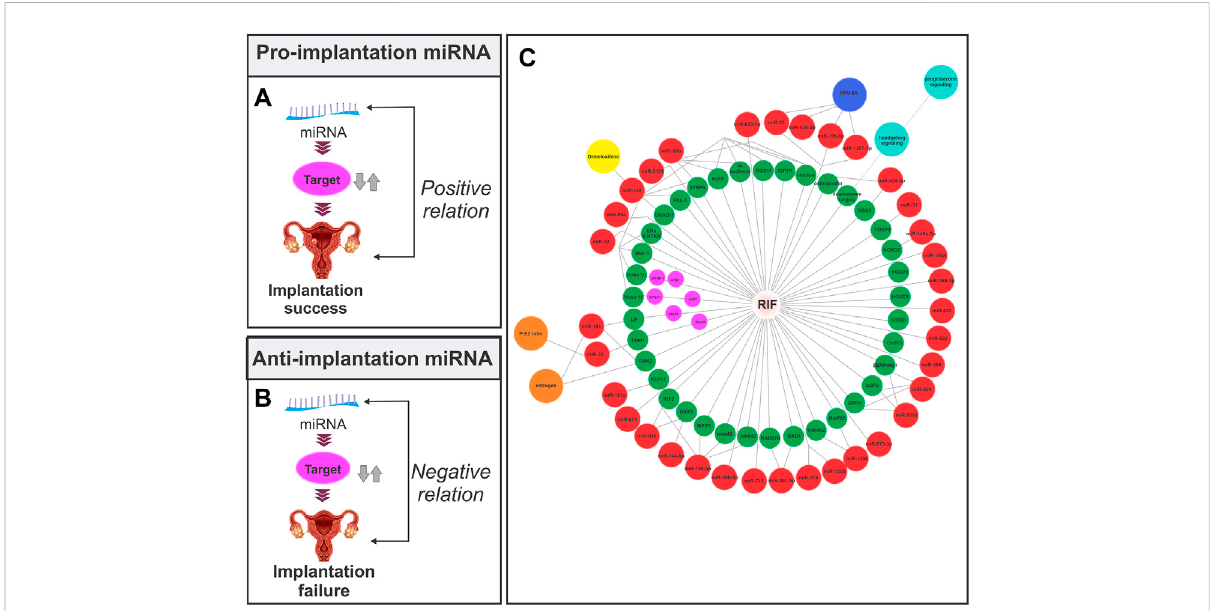
FIGURE 2 Relationship between the endometrial miRNA expression and implantation. (A) Pro-implantation miRNA. The expression of the miRNA has a positive association with the implantation outcome. (B) Anti-implantation miRNA. The expression of the miRNA has a negative association with the implantation outcome. (C) Endometrial miRNAs lead to implantation failure through their effect on target mRNA in the endometrial tissue of RIF patients. The red circle represents miRNA, the green and purple circles represent mRNA, the orange circle represents hormones, the yellow circlerepresentsthedrug,thebluecirclerepresentsthesignalingpathway,andthenavybluecirclerepresentsinfection.ThemiRNA-mRNAnetwork is based on Section 4in this